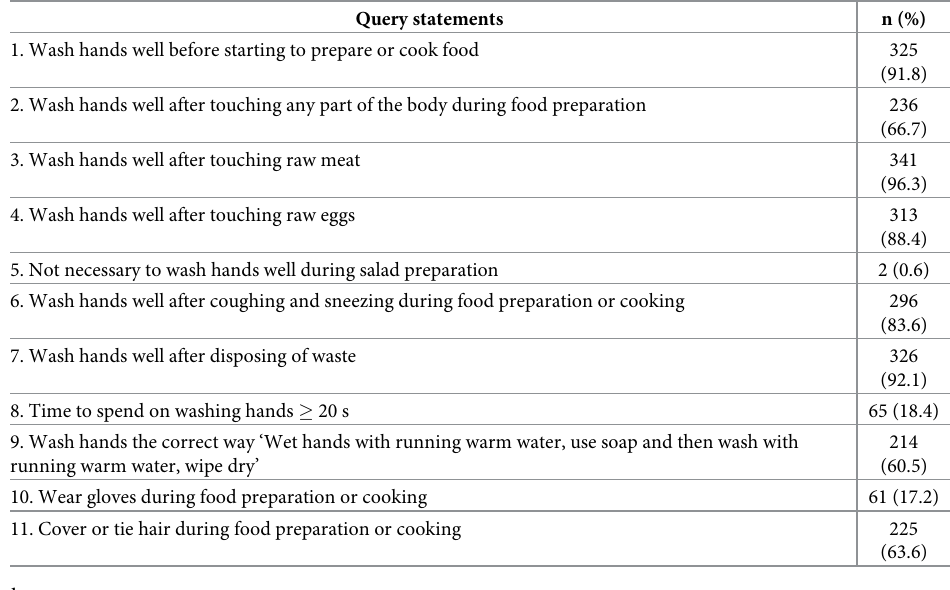
Table 3. Query statements and responses 1 to the “personal hygiene” aspect (n = 354).